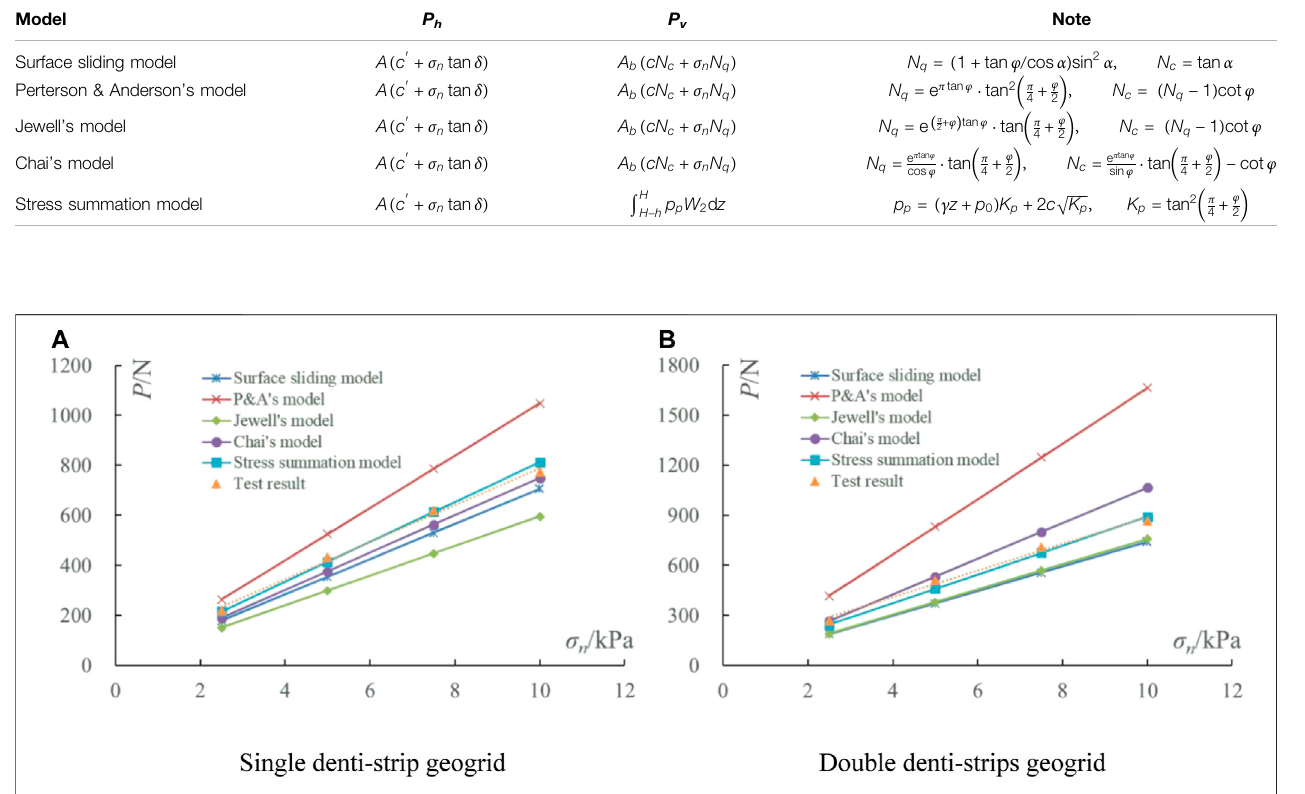
Frontiers in Materials |